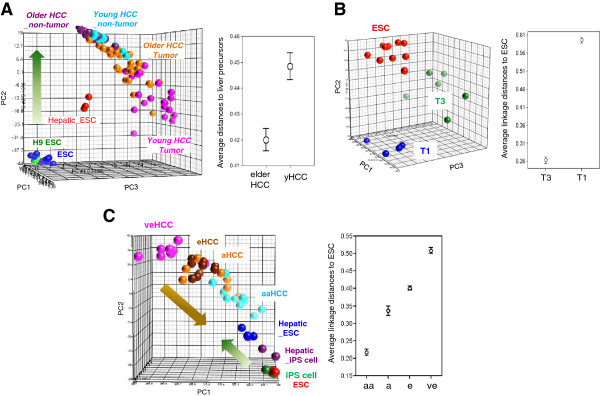
Decreased hepatogenesis characters in yHCCs but increased ESC traits in advanced HCCs. (A) Forfeiting of liver differentiation program in yHCCs. (Left) A PCA plot using genes differentiating the H9 ESCs and day 20 hepatic differentiated progenies (q < 10-4). The transcriptome drift directions during hepatic differentiation are indicated by an arrow. Hepatic_ESC: day 20 (d20) hepatic differentiated progenies. (right) Relationships between liver precursors and HCCs of different age groups. (B) Relationships between ESC and HCC of different histopathological stages. (Left) A PCA plot based on 977 probe sets genes distinguishing early (T1) and late (T3) HCCs from elderly patients. (Right) Relationships between ESC and T1/T3 HCCs. (C) Dedifferentiation-like transcriptome reprogramming during the progression of HCV-related HCC. (Left) A PCA plot using genes differentiating very early (ve) and advanced (a) HCC (q < 0.01, 1700 probe sets). The orange arrow represents the transcriptome drift direction during HCC progression. eHCC, early HCC; aHCC, advanced HCC; Hepatic_iPS cells: day 20 hepatic differentiated progenies of iPS cells. (Right) Relationships between ESC and HCC at different clinical stages.